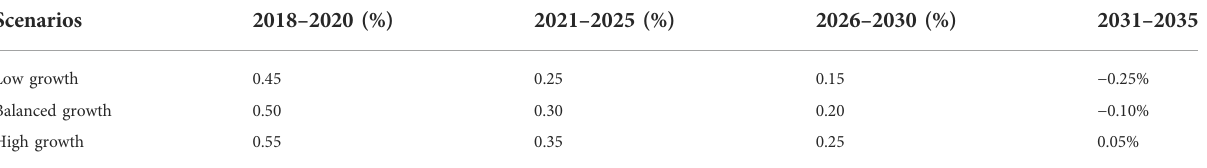
TABLE 1 Population growth rate setting under different